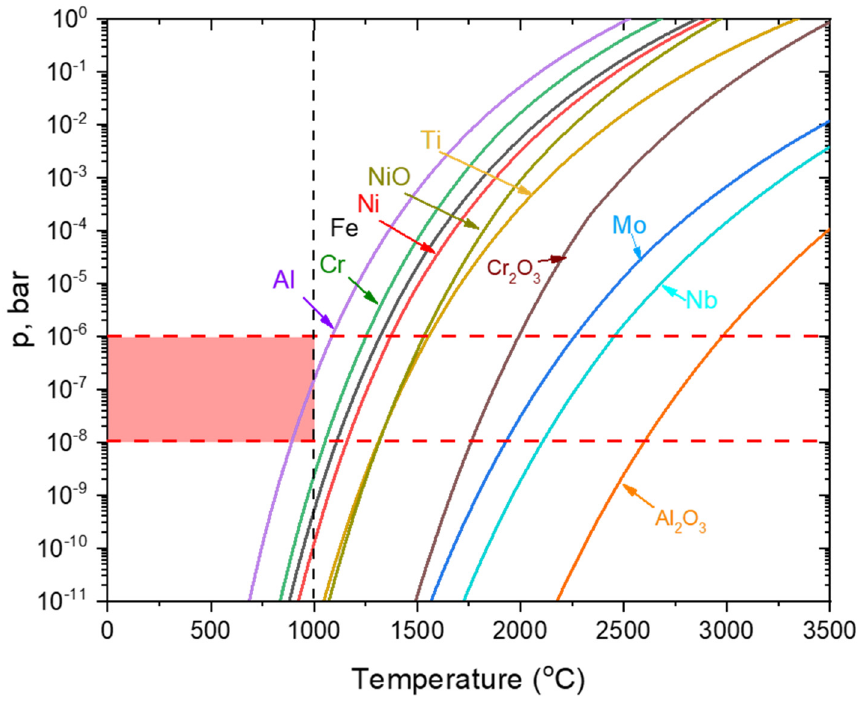
Figure 8. Sublimation pressures of metallic elements present in Alloy 718, based on HSC Chemistry 9.7